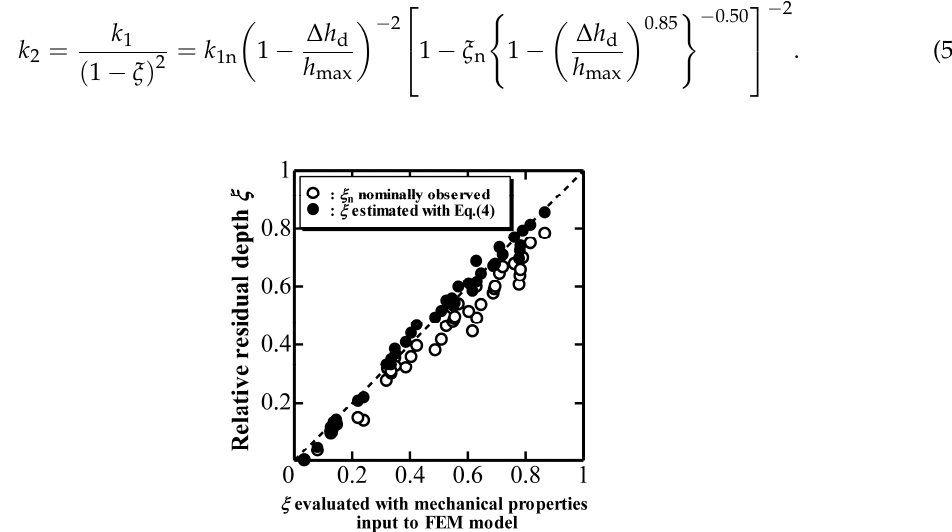
Figure 2. Relative residual depth ξ estimated with Equation (4) and ξ n nominally observed plotted against ξ evaluated with mechanical properties inputted into the FEM model.